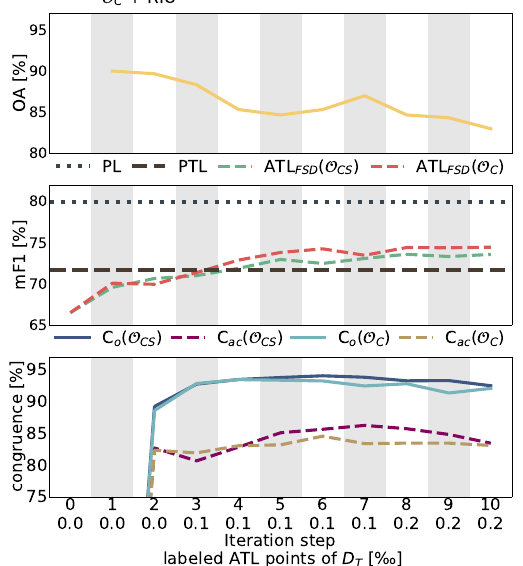
Figure 5. Results obtained for scenario I when relying on a real crowd oracle. We report the overall labeling accuracy of the crowd ( top ) and evaluate the progress of respective AL loops in terms of the mean F1-score ( middle ) and the congruence of predictions ( bottom